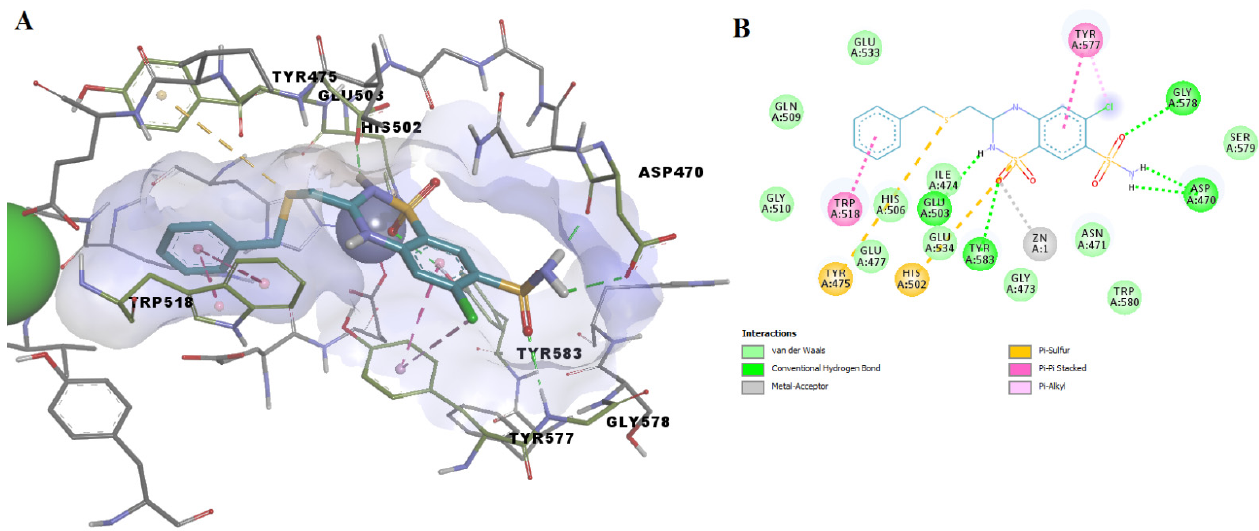
Figure 7. ( A ) 3D binding pose of benzthiazide into ColA active site; ( B ) 2D molecular interactions diagram for benzthiazide-ColA complex.